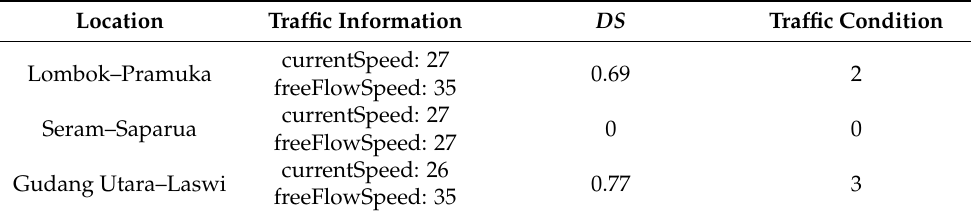
Table 17. The calculation result of saturation degree and traffic condition using